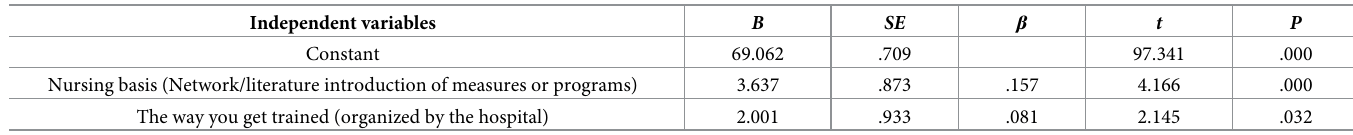
Table 5. Regression analysis of attitude of neurological nurses in